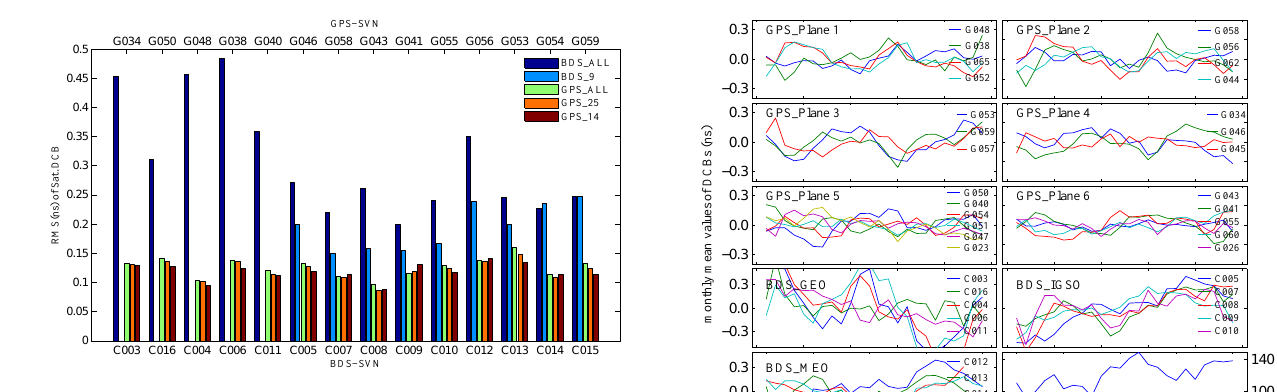
Figure 6. RMS of satellite DCB series estimated from 14 BDS satellites, 32 GPS satellites, and 14 selected satellites. “BDS_ALL’ is the result based on all BDS observations, while “BDS_9” is the result with only BDS MEO/IGSO measurements. “GPS_ALL” cor- responds to all orbiting GPS satellites, “GPS_25” represents avail- able satellites except G061 and G063, and “GPS_14” represents GPS satellites with marked SVN in Fig. 1.